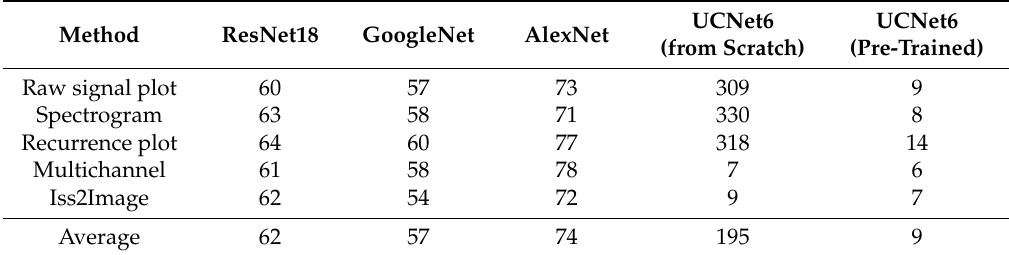
Table 10. Comparison of training times (minutes) on different